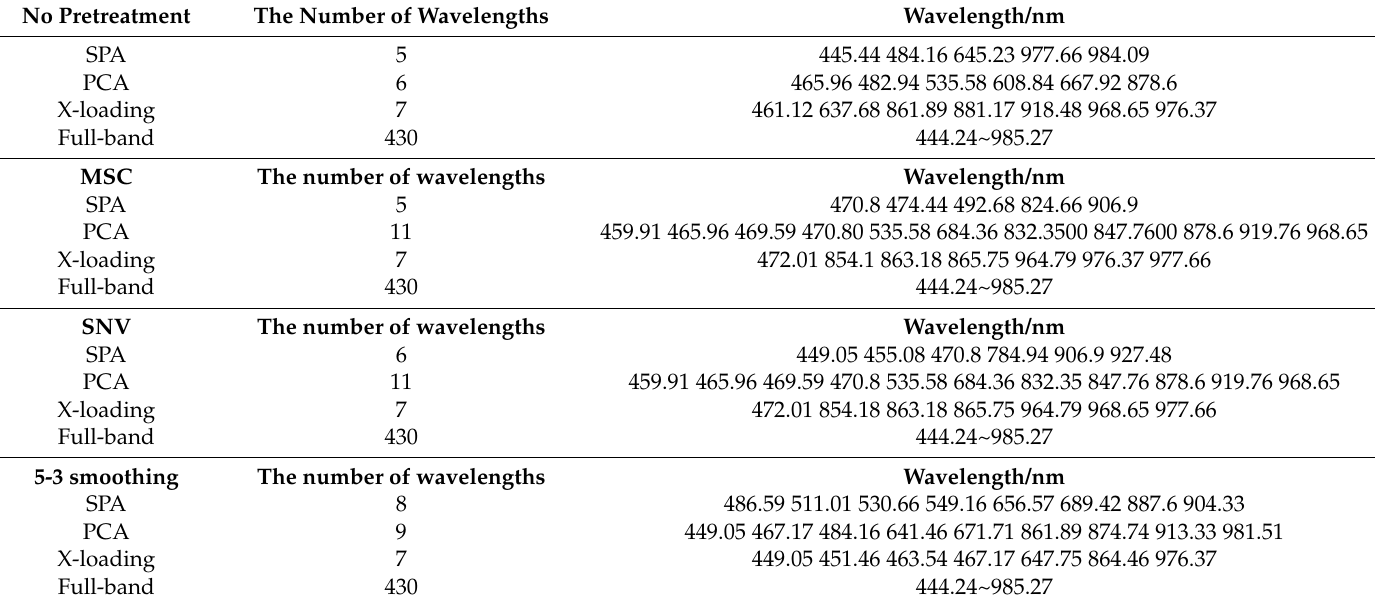
Table A1. The selected wavelengths using different methods under different pretreatments of